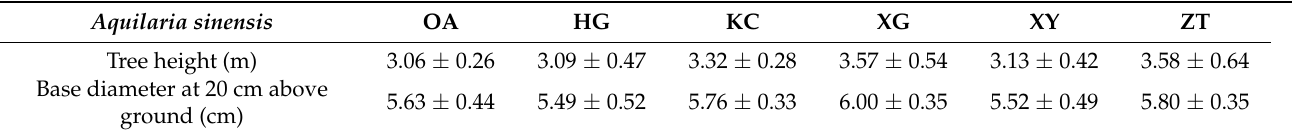
Table 1. The growth status of OA and